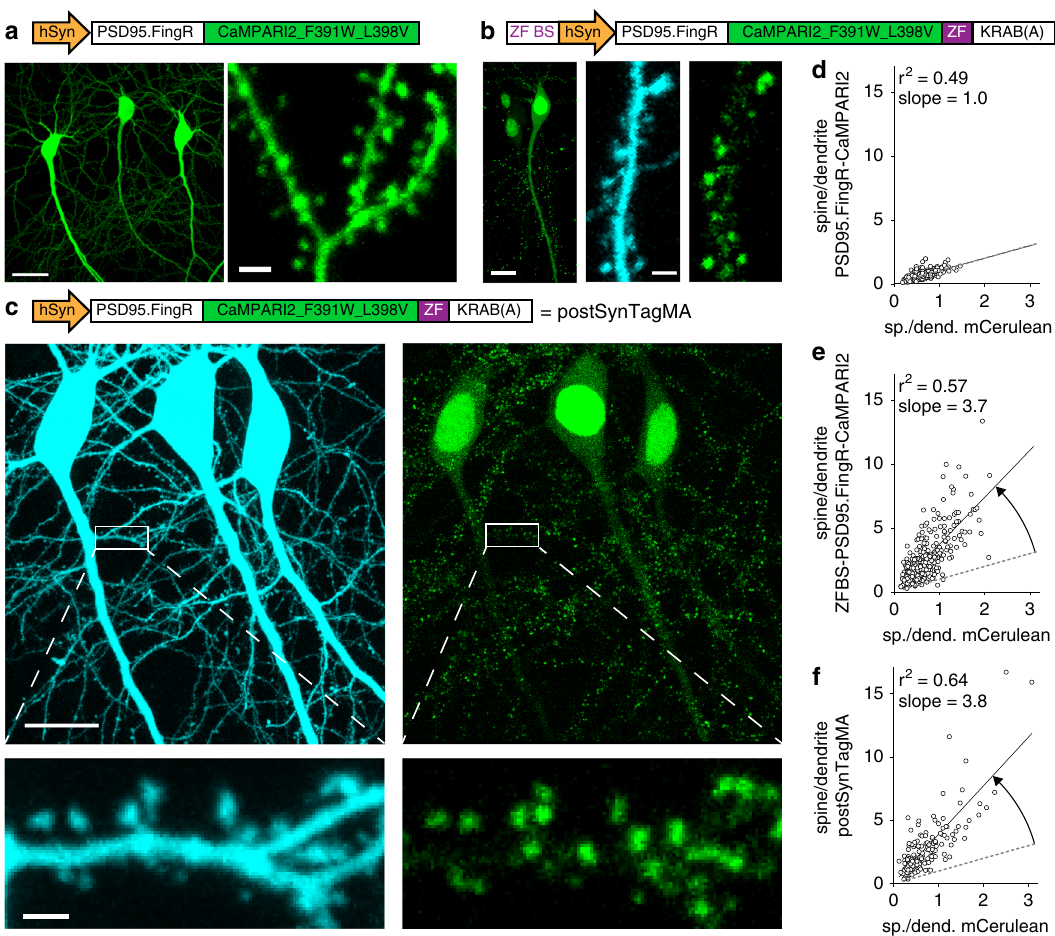
Fig. 3 Postsynaptic targeting of SynTagMA using a PSD95 intrabody. a CA1 neurons expressing the unregulated construct: a fusion protein of PSD95 fi bronectin intrabody (PSD95.FingR) and CaMPARI2_F391W_L398V (without NES or epitope tags). Scale bars: 20 µ m, 2 µ m. b CA1 neurons expressing PSD95.FingR-CaMPARI2 with a zinc fi nger binding sequence (ZF BS) added upstream of the promoter and a zinc fi nger (ZF) fused to a transcriptional repressor domain (KRAB(A)) and mCerulean as a cytosolic fi ller (840 nm). Scale bars 12 µ m (left panel) and 2 µ m (center and right panels). c Postsynaptically targeted SynTagMA (postSynTagMA). As in b , with the ZF-KRAB(A) but no upstream ZF-BS. Note that postSynTagMA is still enriched in spines and the nucleus, leaving the cytoplasm almost free of SynTagMA. Scale bars: upper 20 µ m, lower 2 µ m. d The unregulated construct is expressed at high levels, leading to near-identical concentrations in dendrites and spines. For individual spines (circles), the spine-to-dendrite green fl uorescence ratio was similar to the mCerulean spine-to-dendrite ratio ( n = 348 spines, 4 neurons). e The construct with autoregulatory elements shuts off its own production, resulting in strong enrichment in spines ( n = 367 spines, 3 neurons). f The construct without zinc fi nger binding sequence (postSynTagMA) is also auto-regulated, showing equally strong enrichment in spines ( n = 179 spines, 3 neurons). All images are two-photon (2P) maximum intensity projections. In d , e and f , the black line is the linear fi t to data points and the dotted line is the unity